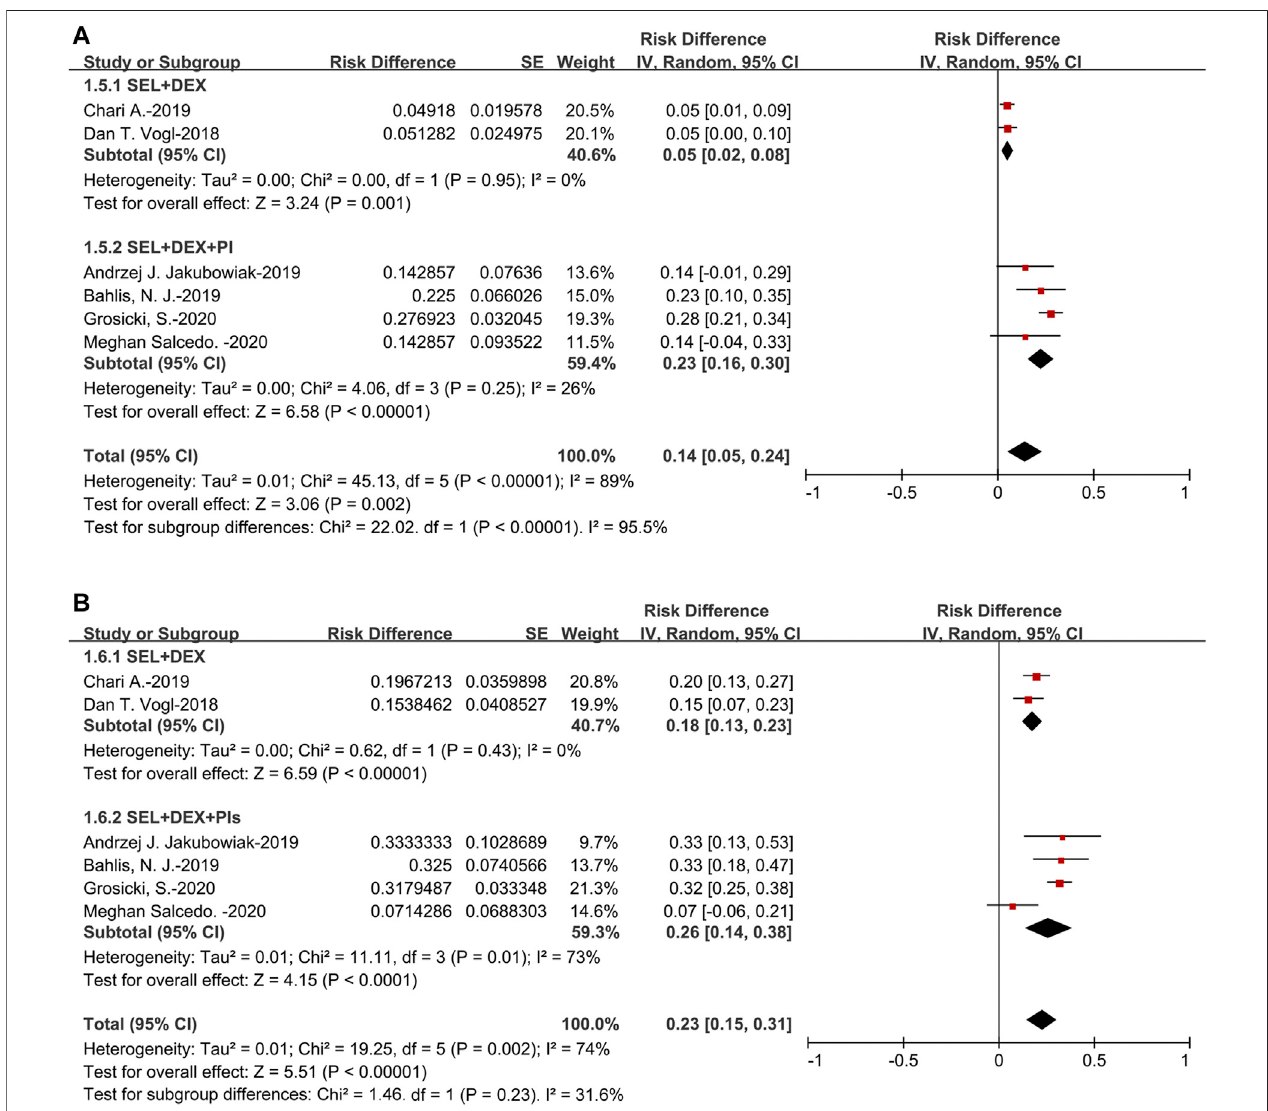
FIGURE 4 | The forest plot of pooled (A) VGPR, and (B) PR.